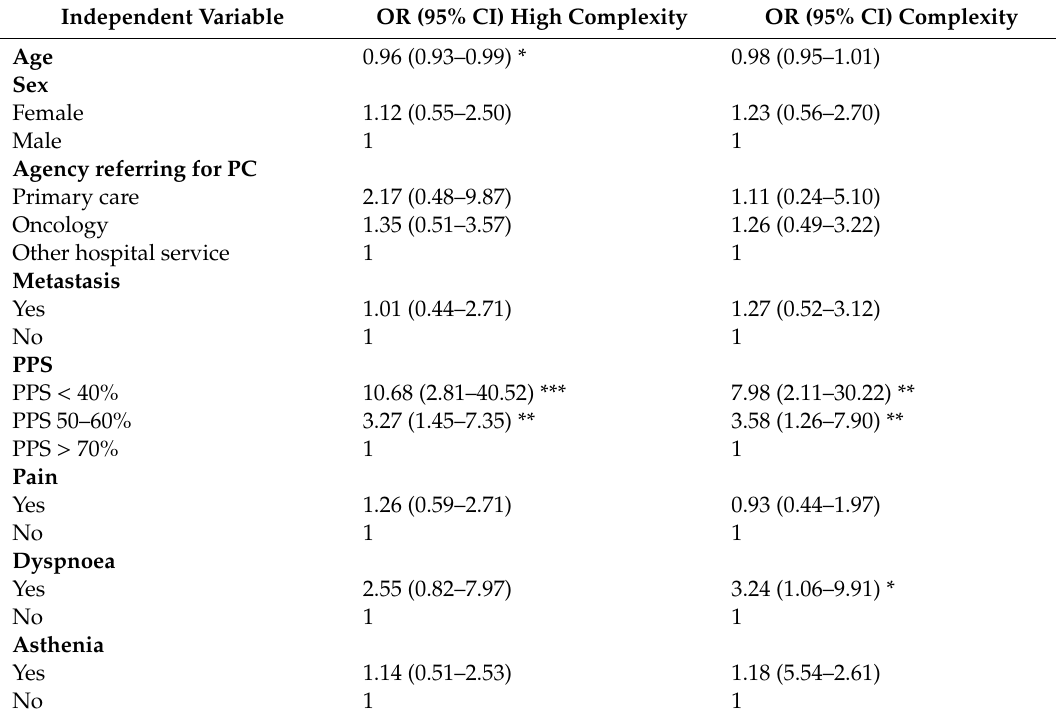
Table 4. Factors related to level of palliative complexity. Multinomial logistic regression for high complexity and complexity (with respect to